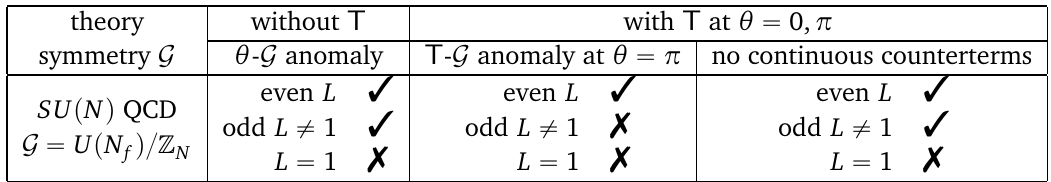
Table 4: Summary of anomalies and existence of continuous counterterms